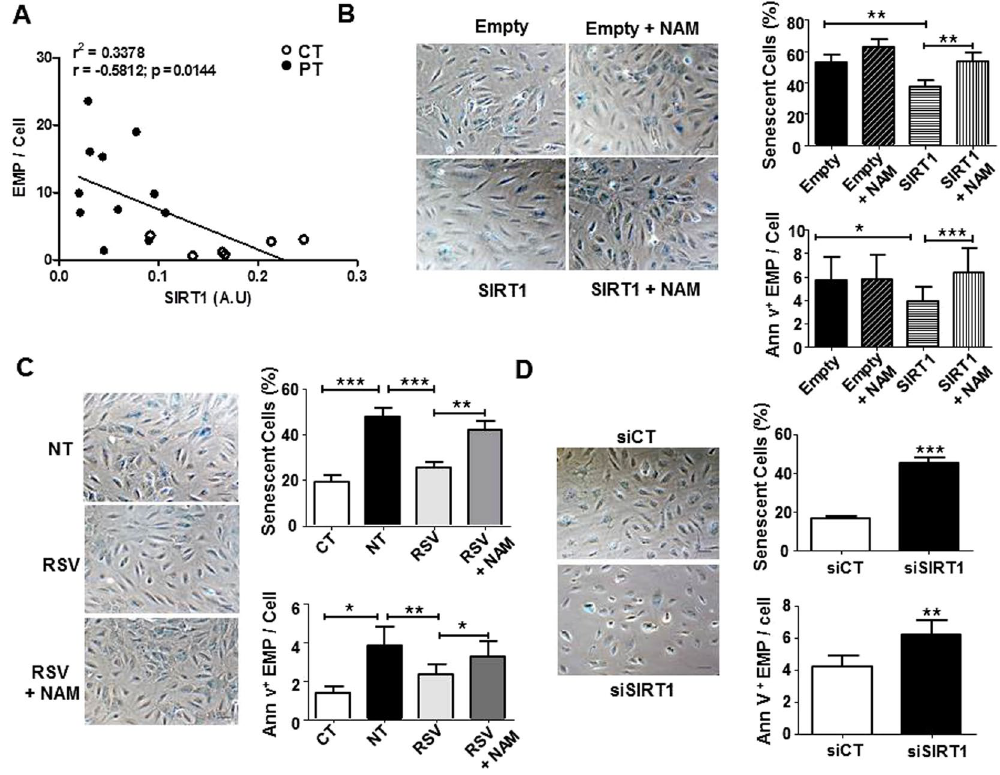
Figure 3. SIRT1 defect drives the senescence-associated EMP release induced by prematurity. ( A ) Correlation between Annexin-V + EMP release and SIRT1 protein levels. Every dot represents a single sample collected from term or PT neonates (N = 17). ( B–D ) Representative images and the quantification of ECFC positive for SA β -galactosidase activity (original magnification × 20, scale bar, 49 µ m) and the quantification of EMP release by flow cytometry using Annexin-V staining. ( B ) The effect of SIRT1 overexpression on PT-ECFC (48 h, N = 14). PT-ECFC were transiently transfected with pCMV-sport6 vector (Empty) or the pCMV-Sport6-SIRT1vector (SIRT1), and treated or not with nicotinamide (NAM, 1 mM). ( C ) The effect of SIRT1 modulation by resveratrol (RSV) treatment on PT-ECFC (48 h, N = 18, CT = 9). PT-ECFC were treated with solvent alone (NT) or 1 µ M of resveratrol (RSV, in the presence or absence of 1 mM of NAM ( D ) The effect of SIRT1 silencing on CT-ECFC (48 h, N = 11). CT-ECFC were transiently transfected with control siRNA (siCT) or SIRT1 siRNA (siSIRT1). The data for all of the bar graphs are presented as the means ± SEM. (Statistical analysis: One-way ANOVA, t-test; * p < 0.05, ** p < 0.01, *** p <